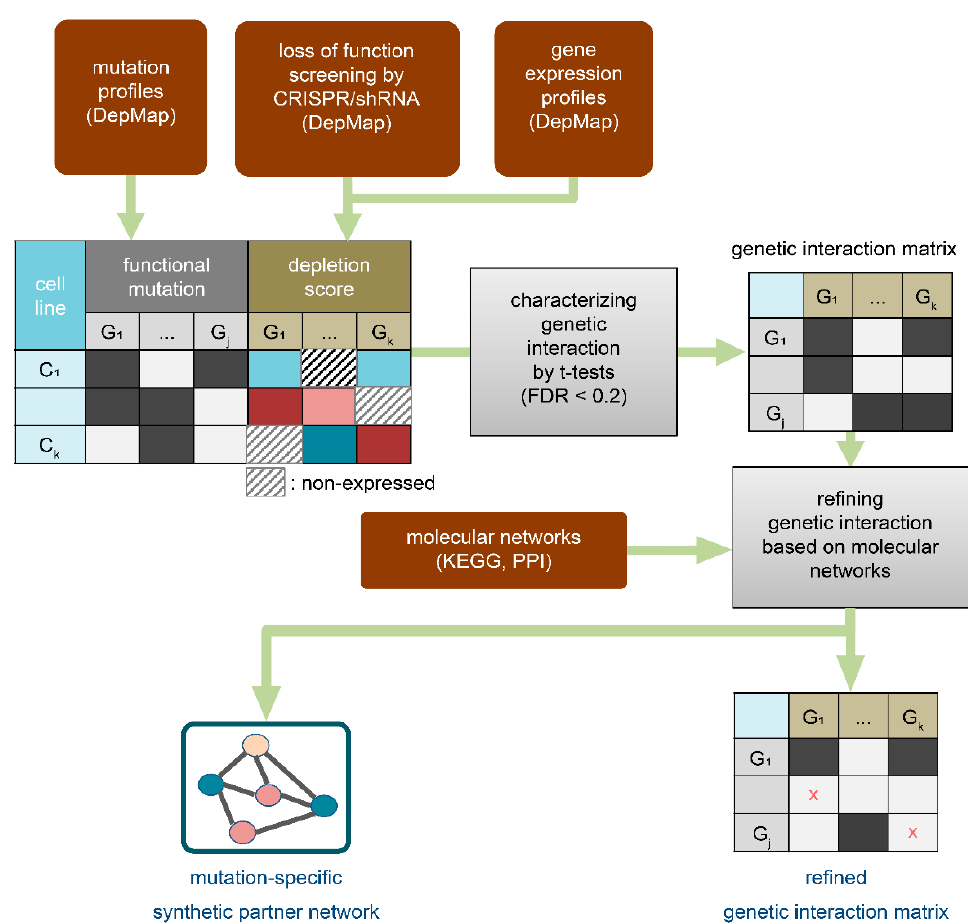
Figure 1. Strategy overview. The genetic interaction (GI) between a mutated gene Q and a gene K was characterized when the knockout/knockdown of gene K statistically caused cancer death or proliferation in cells harboring mutated gene Q. To quantitatively estimate this, a t -test was applied to depletion scores from loss-of-function screening (CRISPR and shRNA) between cells with mutated and normal genes, where the depletion scores of nonexpressed genes were excluded. In addition, the characterized GIs were further refined by incorporating the KEGG or PPI networks based on the assumption that genes genetically interacting with a certain mutated gene (i.e., synthetic partners of a certain mutated gene) are located adjacent in the networks. The objective of these two processes was to diminish potential false predictions. As a result, we obtained a refined set of GIs and a synthetic partner network (SPN) for each mutated gene.